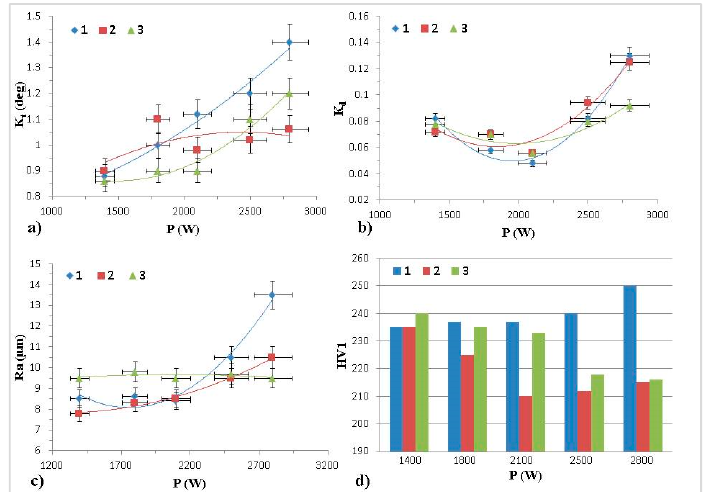
Figure 5. Cut quality vs. laser power and focus position: ( a ) Kerf taper, ( b ) Kerf deviation, ( c ) average roughness, and ( d ) microhardness. 1—material top, 2—material bottom, 3—0.5 mm in front of material.